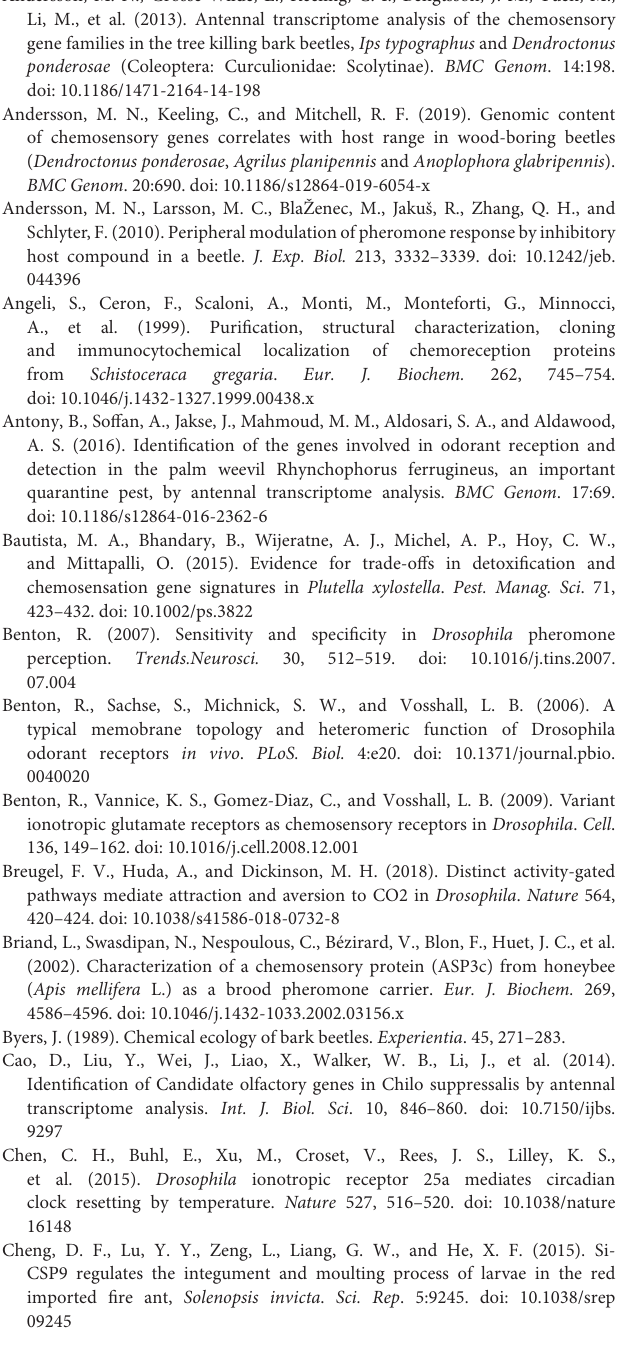
Supplementary Figure 3 | Uncropped gel images for candidate ScosOBPs and ScosCSPs. Supplementary Table 1 | Forward and reverse primer sequence used in RT-PCR. Supplementary Table 2 | Sequence